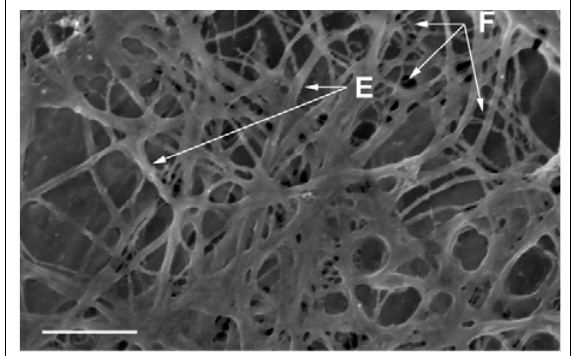
FIGURE 3 Scanning electron microscope image of fibrin network from dog suffering from ischaemic stroke, 15 minutes after treatment